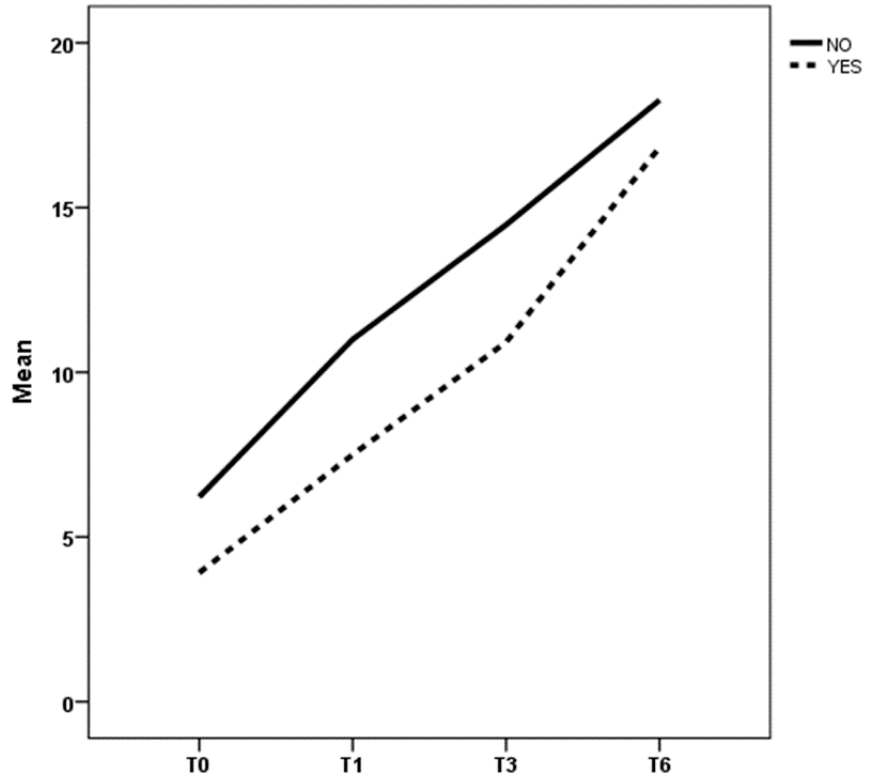
Figure 4. Caption. Trend of mean clinical scores at T0, T1, T3, and T6 considering overall sphincteric anomalies in all patients. YES: patients with anomalies; NO: patients without anomalies. During all treatment, no complications or problems were observed and no patient abandoned the procedure. 4. Discussion Transanal irrigation (TAI) is a non-surgical alternative which empties the bowel from approximately the rectal ampulla to the splenic flexure, thereby preventing fecal leakage between treatments. The idea is to keep the colon empty for suitable periods of time, in order to regain its propulsive ability and reestablish the control of defecation [1–4,15,16]. The efficacy and success of TAI with the use of Peristeen ® has been widely demonstrated also in children, with description of a standardized approach [10]. However, while some authors report constant results of efficacy in short- and long-term studies, in some cases a reduction of the success rate during follow-up is described [7,10]. In the literature, several studies show the high efficacy of Peristeen ® in several organic diseases, as well as in func- tional disorders [17–23]; however, to our knowledge, there are no studies comparing the effectiveness of TAI in patients affected by different pathologies. Furthermore, the actual